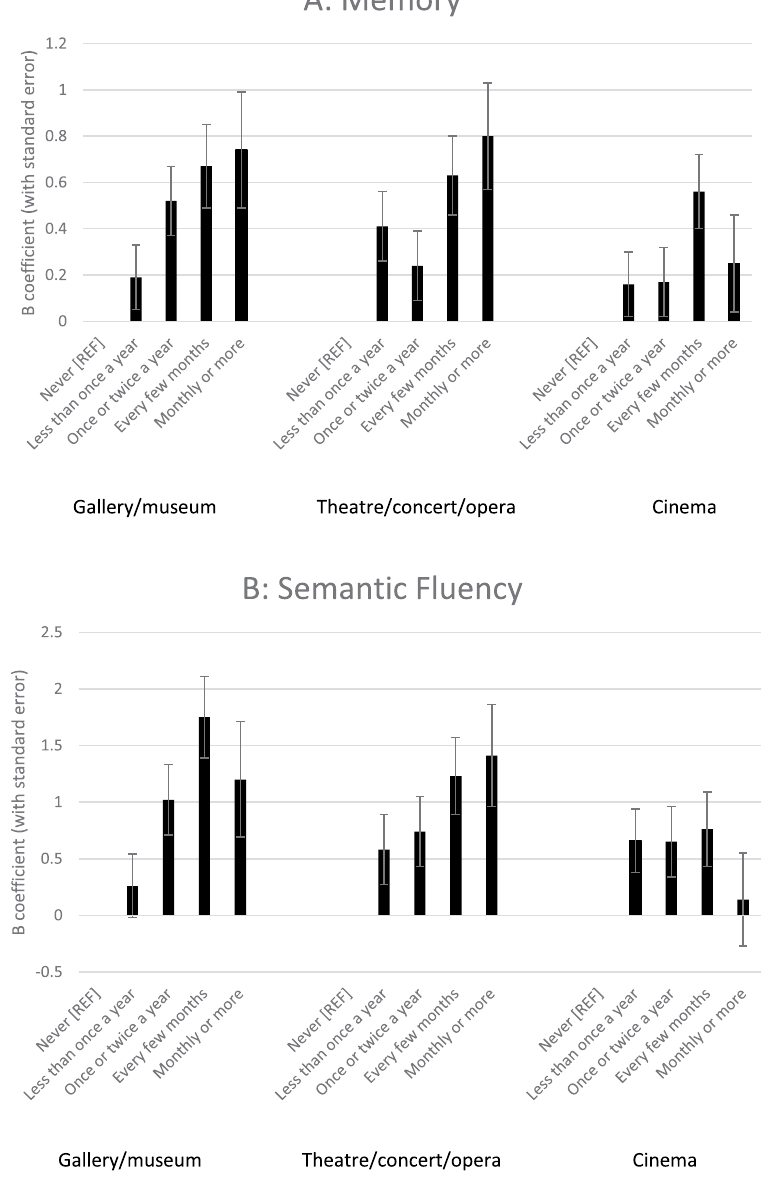
Figure 1. Associations between cultural engagement and ( A ) memory ( B ) semantic